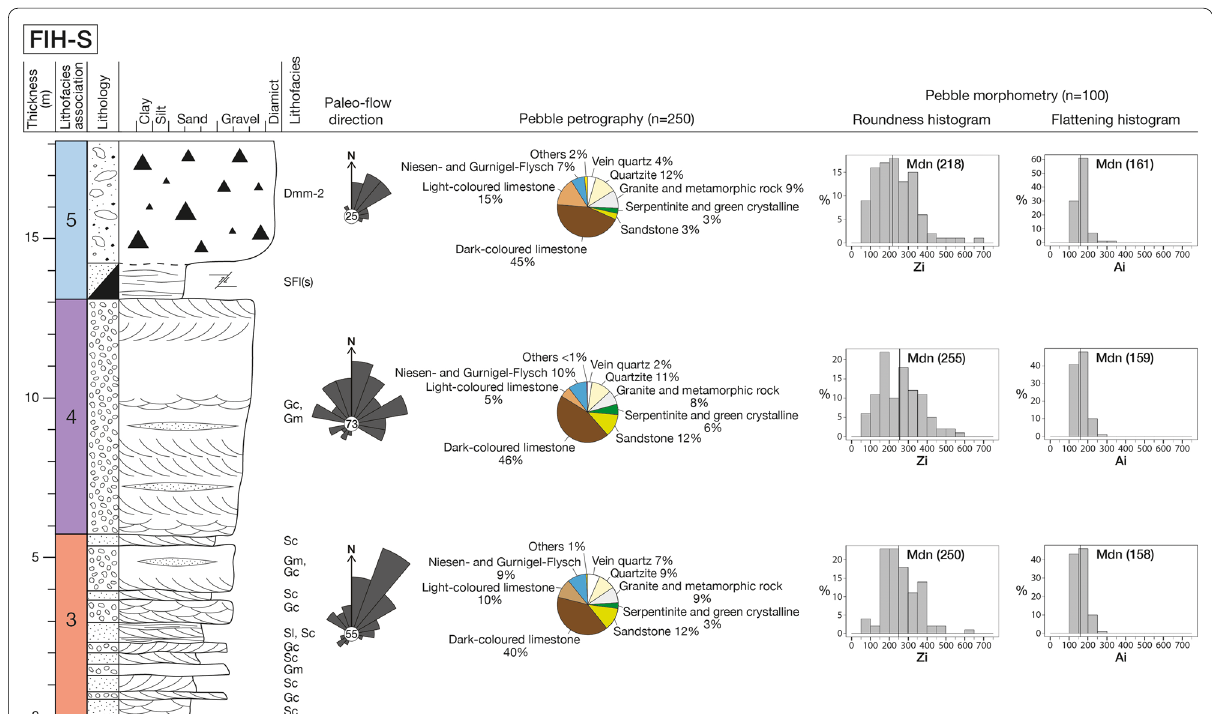
Fig. 7 Sedimentological log shows the sedimentary record at Finsterhennen southern part (FIH-S; CH1903 top of LFA 5 situated at 466.1 m a.s.l.) with (i) lithofacies associations (LFA; Table 2), lithofacies (LF; Table 1), (ii) paleo-flow directions, (iii) pebble petrography, and (iv) pebble morphometry. See Fig. 2 for the location of the log, and Fig. 5 for the